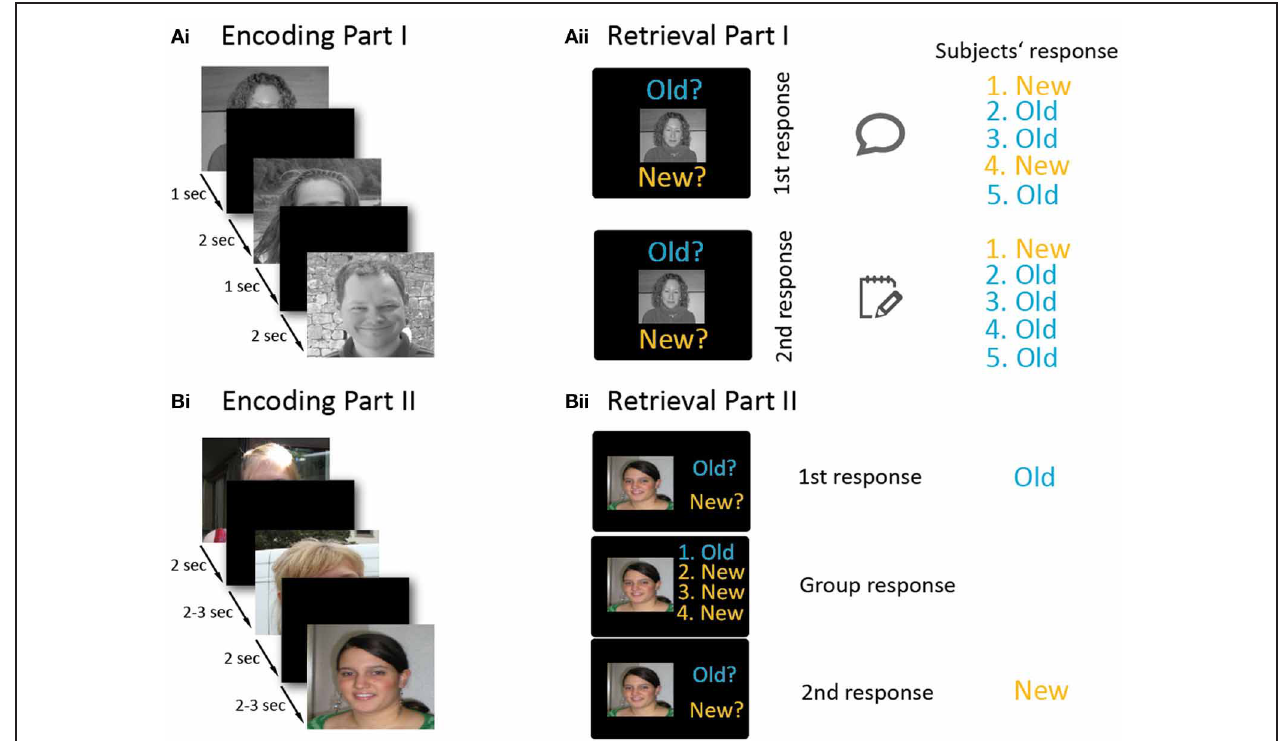
FIGURE 1 | Overview of the experimental paradigm. The experiment involved two parts (A and B) , and each part consisted of an encoding (Ai,Bi) and a retrieval phase (Aii,Bii) . Part I (A) was conducted in a non-manipulated group setting. During the encoding phase (Ai) , participants memorized 50 stimuli which were consecutively projected onto a screen. In the retrieval block (Aii) , old and new stimuli were presented. For each stimulus, participants first indicated their old/new response by holding up a response tag. After viewing the responses of the other participants, they wrote down their final decision onto a sheet (which was invisible to the other